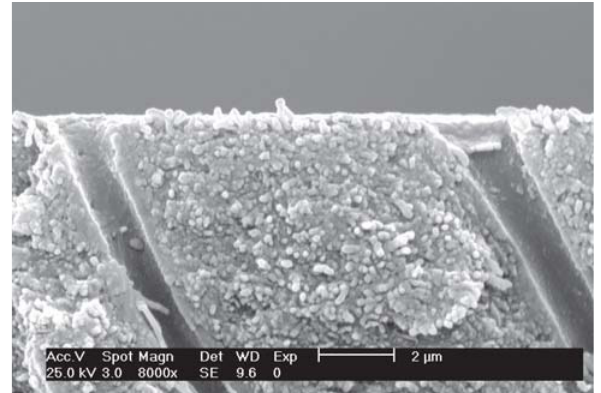
FIGURE 8- SEM micrograph of group 4 (Clearfil SE Bond) - Occlusal view of dentin surface. Observe the cuff-like aspect of the peritubular dentin (arrow) and the aperture of the exposed dentinal tubules (x8,000)